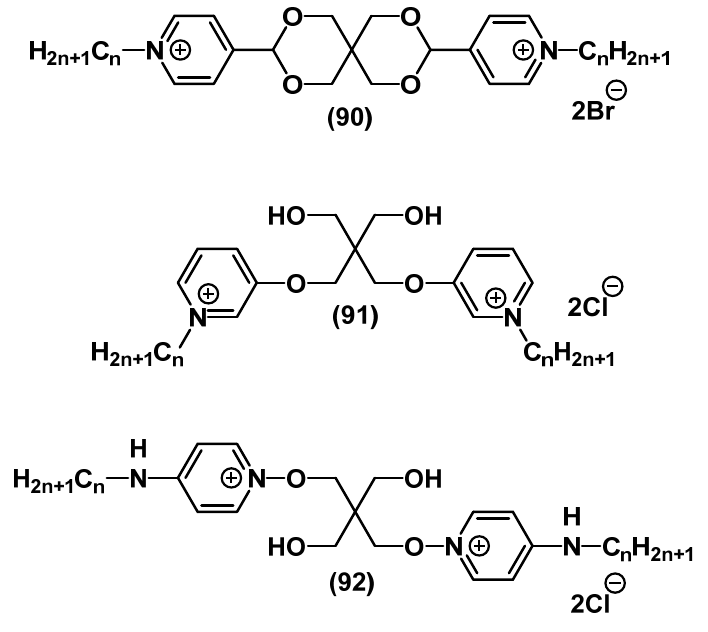
Figure 29. Pyridine-based bis-QACs containing pentaerythritol. An overview of the antibacterial activity of bis-QACs, analyzed in the review, is shown in Table 4. Table 4. Antimicrobial activity of Bis-QACs *.